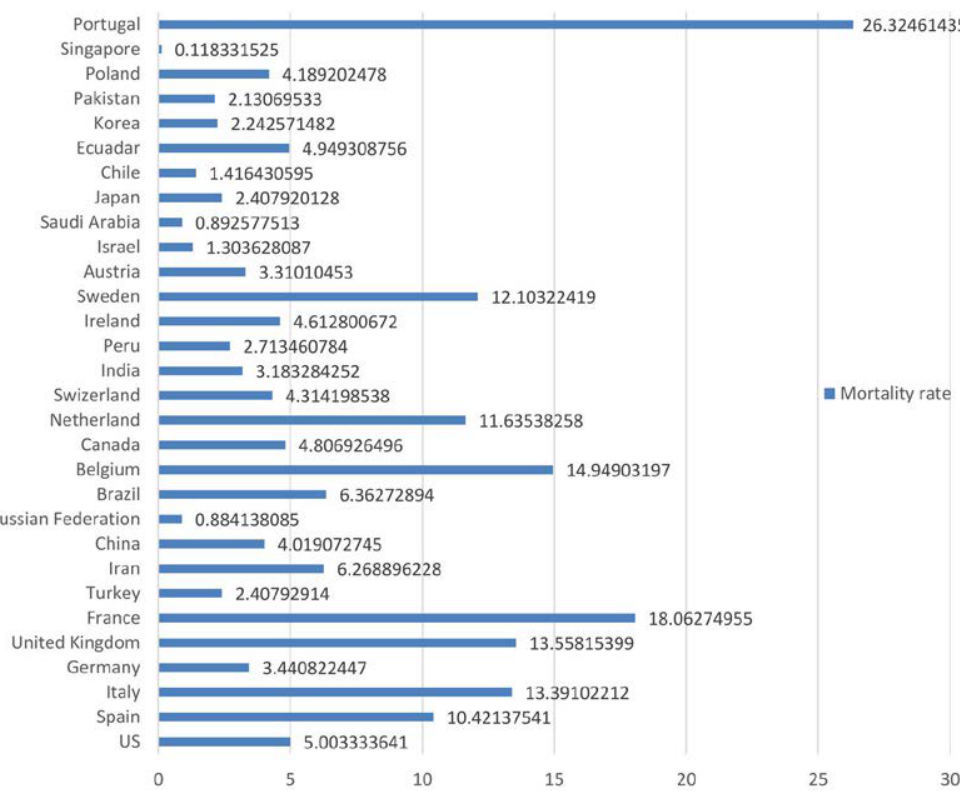
Fig. 4. The mortaliy rate of COVID-19 in various Countries